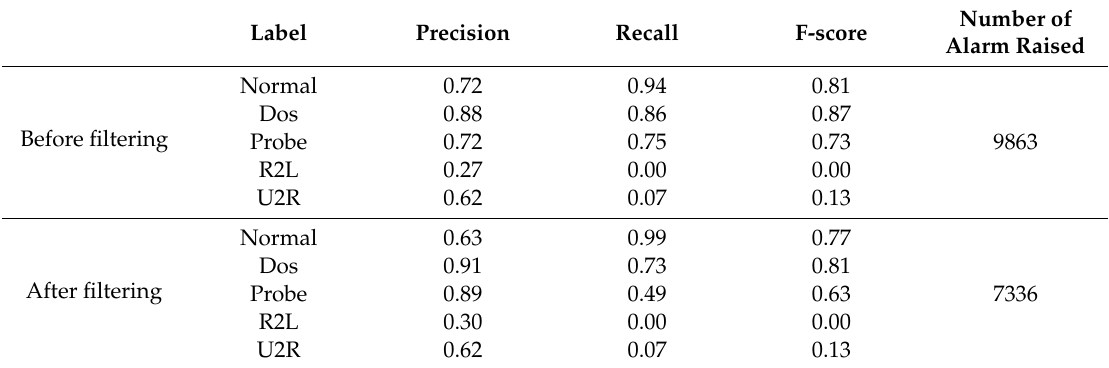
Table 11. Result of five classifications before and after filtering, based on the NSL-KDD test set.